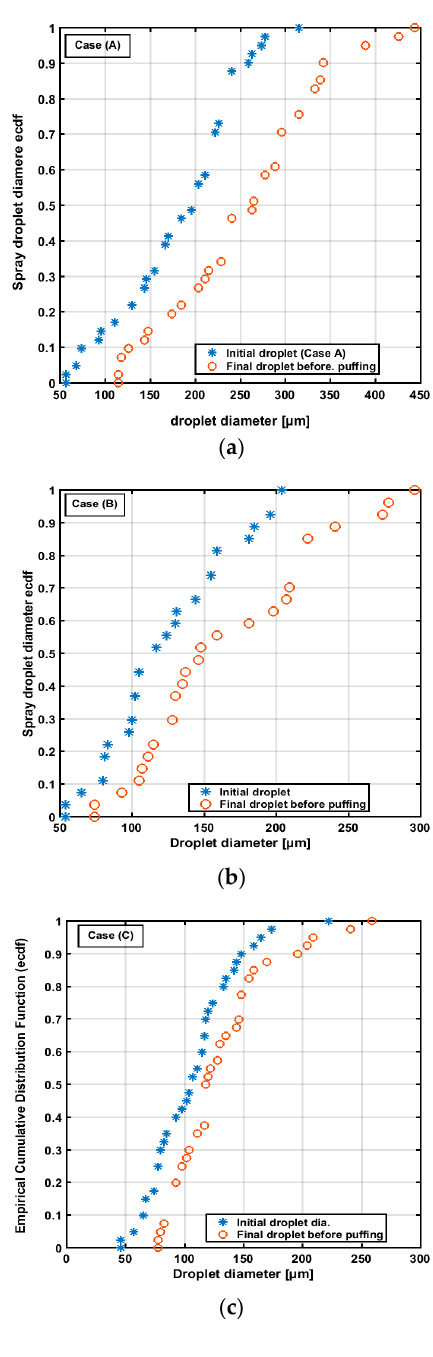
Figure 7. The empirical cumulative distribution function (ECDF) shows the spar initial droplet size versus the droplet expansion before puffing for different injection pressures: ( a ) Case A (500 bar), ( b ) Case B (1000 bar) and ( c ) Case C (1500 bar). As the dispersed water droplet size decreased via the injection pressure, the droplet expansion was decreased.